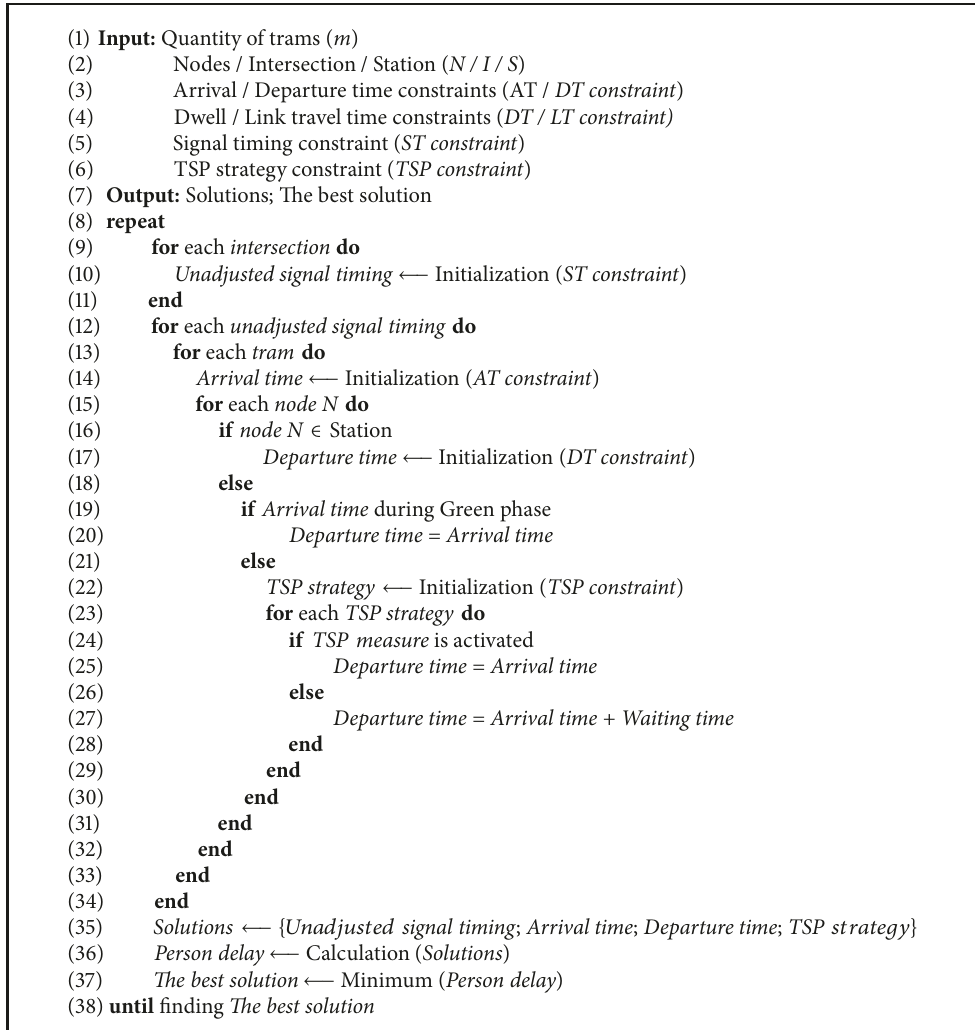
Algorithm 2: The enumeration procedure for the numerical